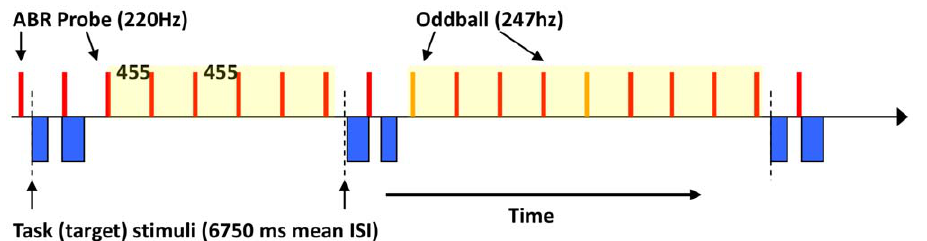
Figure 1. The experimental paradigm. Non-task relevant ABR-eliciting stimuli per presented every 455 ms, with task target stimuli occurring asynchronously, randomly presented (6750 ms mean ISI). Only background tones falling between task stimuli (shaded area) were used in the analysis.